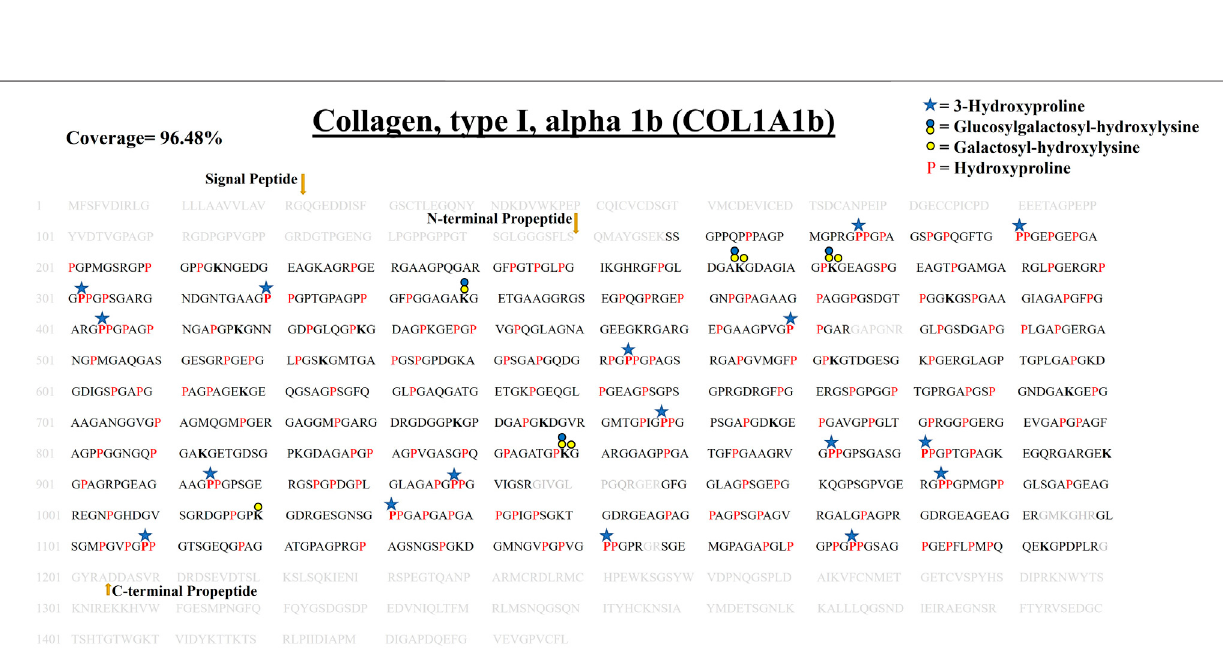
Frontiers in Molecular Biosciences |